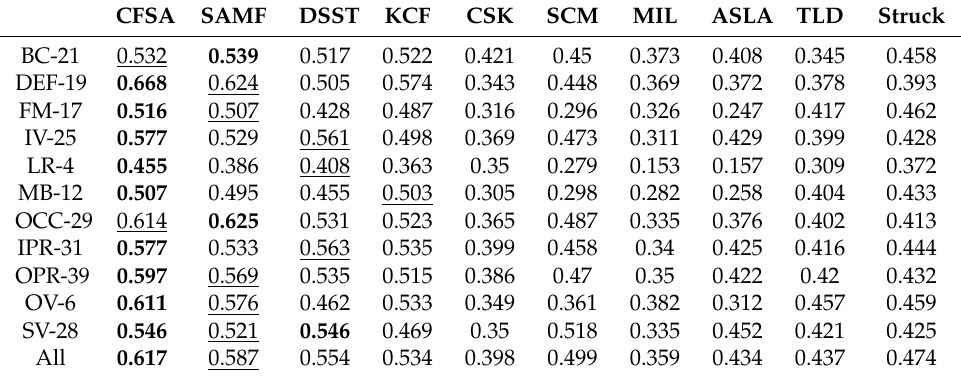
Table 2. The success plot’s area under curve scores of CFSA tracker and nine other state-of-the-art trackers on the OOTB dataset. Bold and underline values indicate best and second performances, respectively.